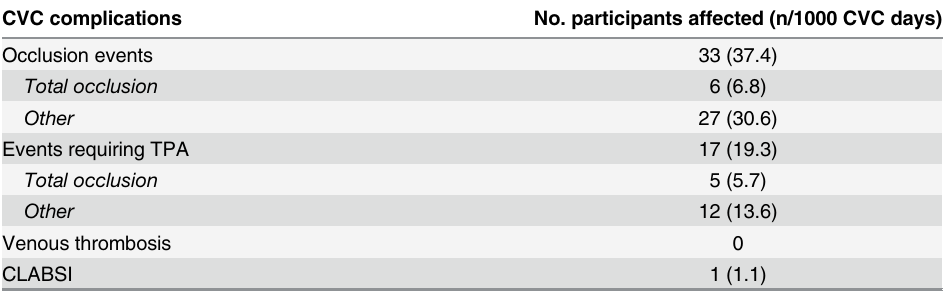
Table 2. CVC-related